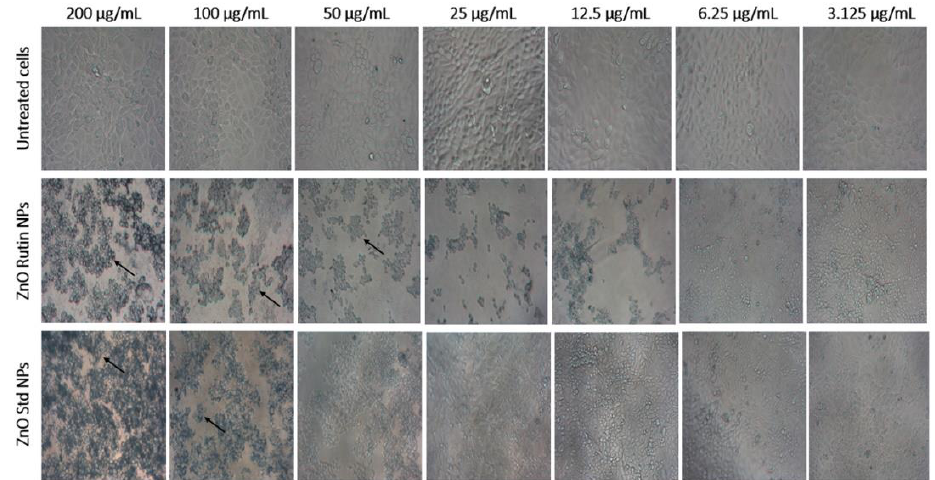
Figure 8. Bright-field micrographs obtained at 20× magnification of cells treated at various concen- trations of ZnO NPs.